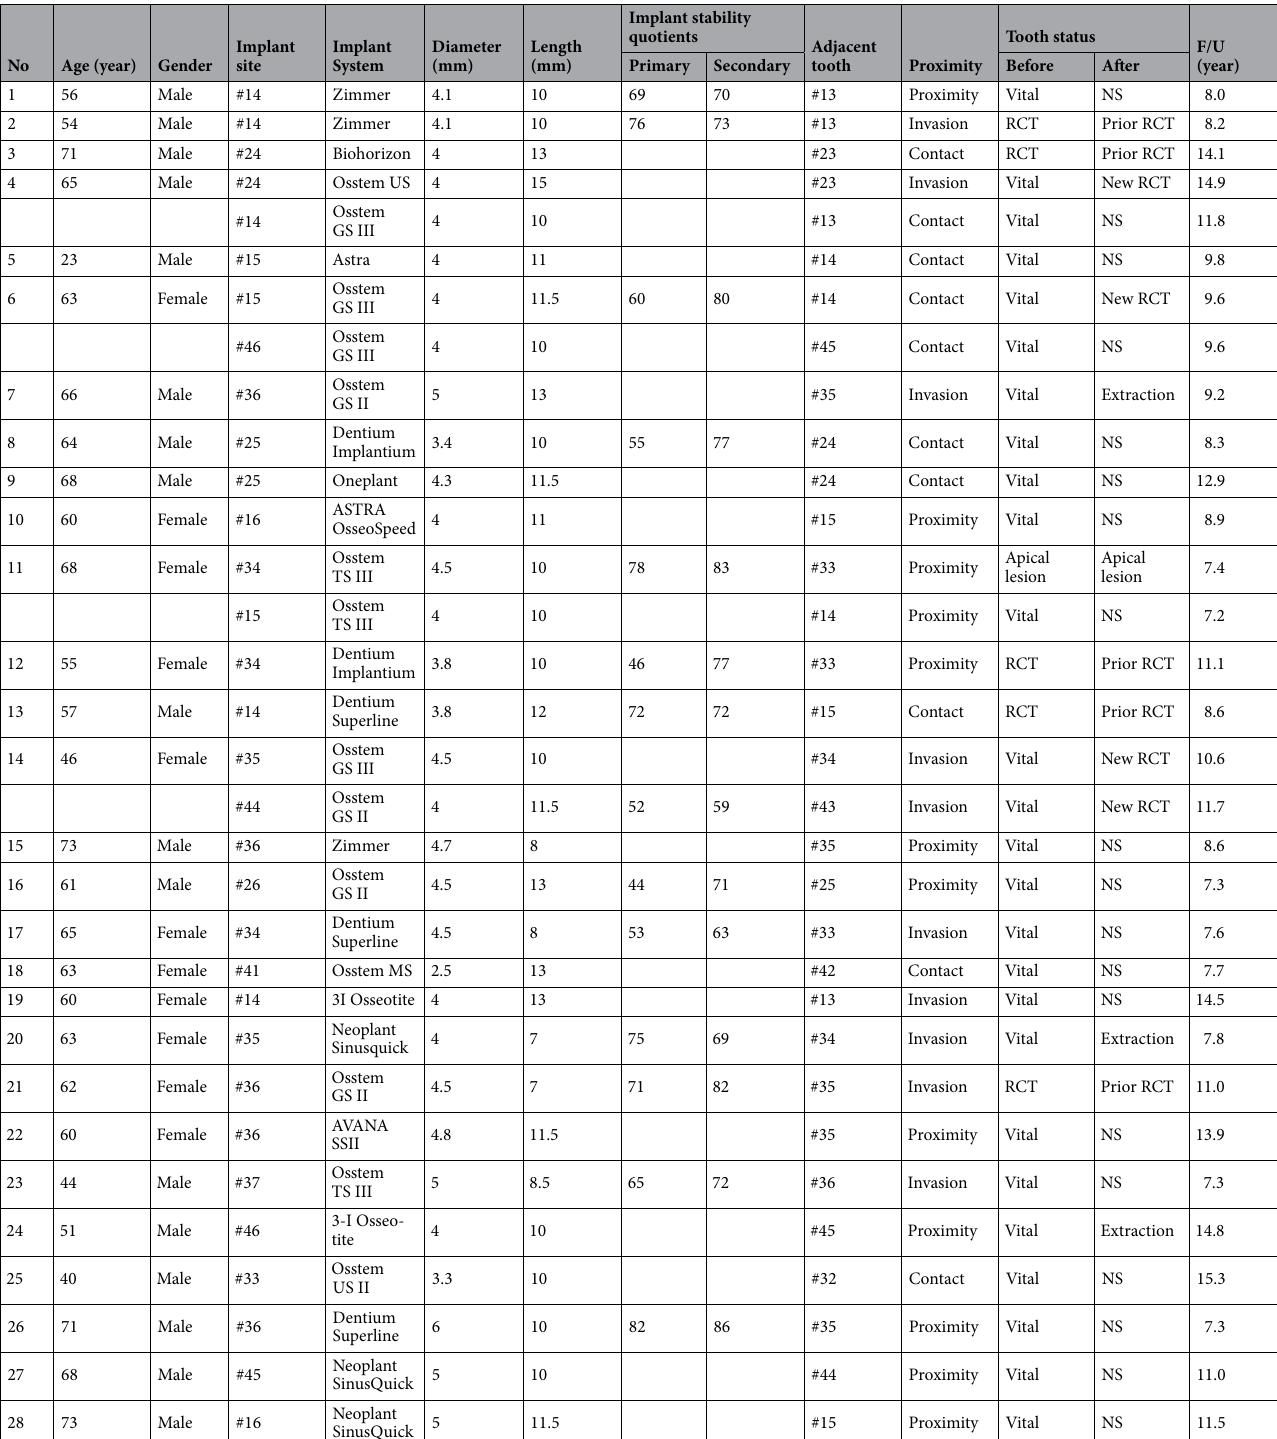
Table 1. Patients record of implant injury on the adjacent teeth. * FDI tooth numbering system. F/U (follow-up), RCT (root canal treatment), Prior RCT (RCT prior to implant surgery), New RCT (RCT after surgery due to apical lesion or symptoms onset), NS (non-specific